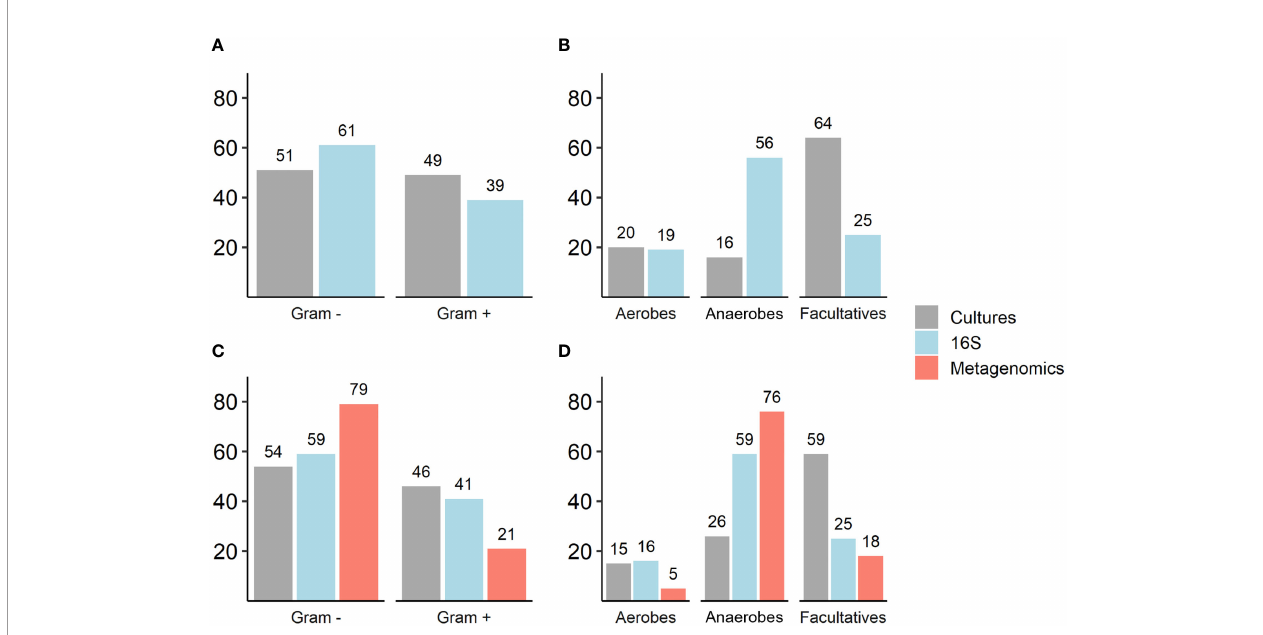
FIGURE 2 | (A – D) . Comparison of Gram staining characteristics and oxygen requirements of isolated and sequenced bacteria as re fl ected by traditional cultures, 16S rRNA and metagenomic sequencing. Numbers represent percentages (%); (A, B) Traditional cultures vs. 16S rRNA sequencing results (N=30): Gram staining, p=0.07; oxygen requirements (anaerobes and facultative anaerobes, p<0.001). (C, D) Traditional cultures, 16S rRNA sequencing and metagenomic sequencing results (N=13): Gram staining, p=0.01; oxygen requirements (anaerobes, p<0.001; facultative anaerobes,